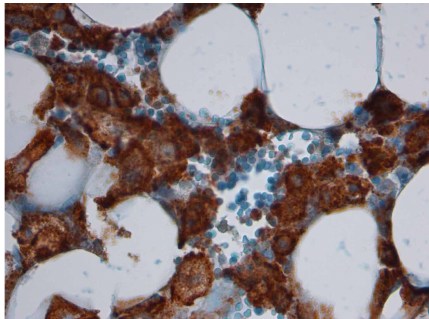
Figure 2: Bone marrow with extensive hemophagocytosis (CD 163,